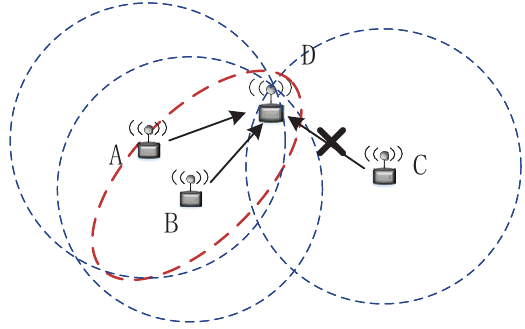
Figure 1. Communication mode of OO.